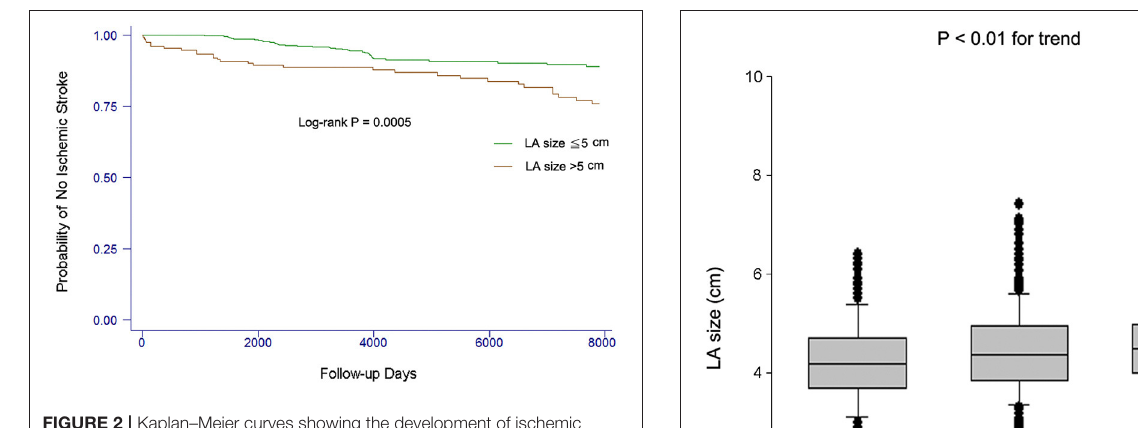
FIGURE 2 | Kaplan–Meier curves showing the development of ischemic stroke among patients with different LA sizes. The log-rank analysis showed significant difference ( P < 0.001).